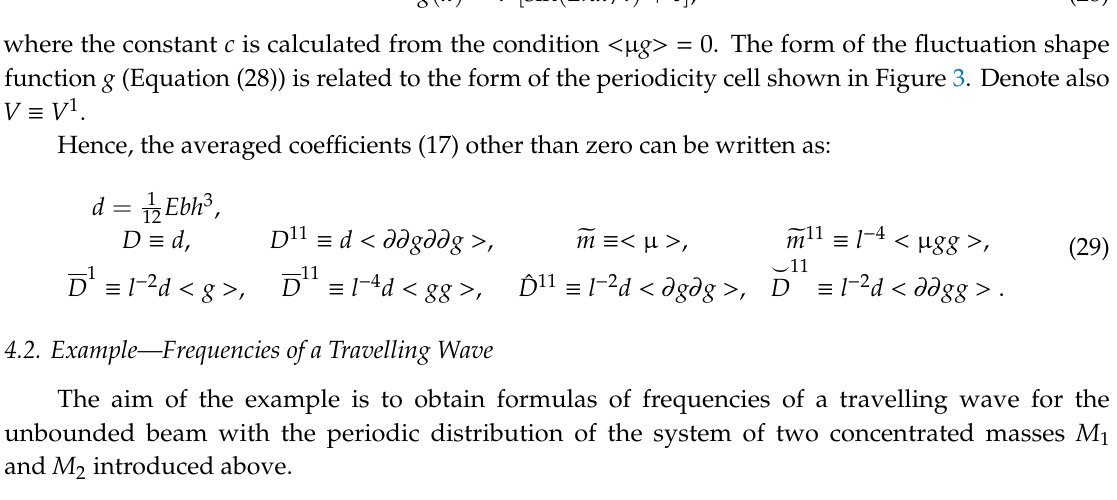
Figure 3. The periodicity cell of the considered beam.